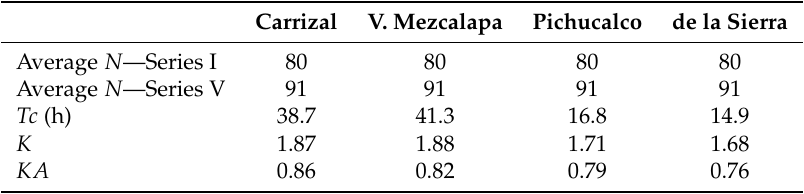
Table 3. Parameters used to calculate flood discharges from Equation (1).